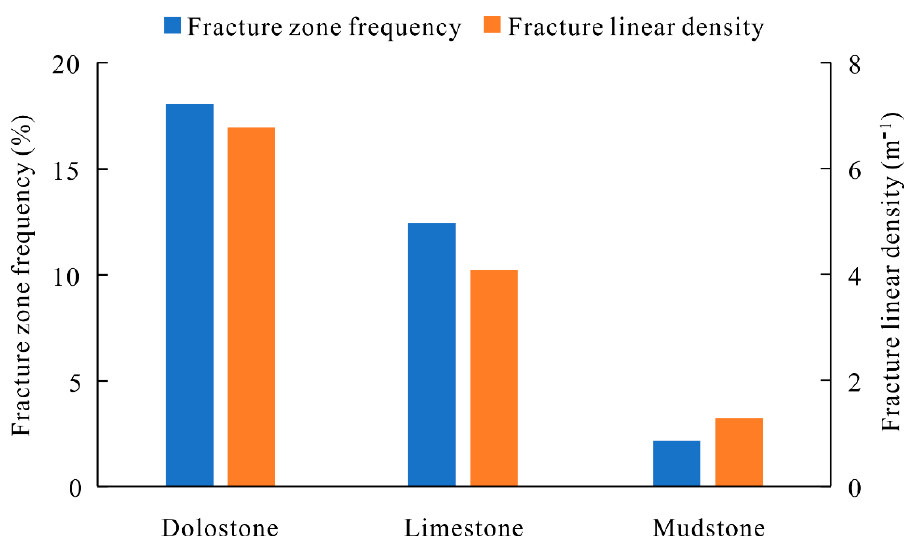
Figure 12. Schematic diagram comparing the fracture zone frequency and fracture linear densities of tectonic fractures in different lithologies. The fracture zone frequency refers to the ratio of the fracture zone thickness to the rock thickness based on borehole image logs.